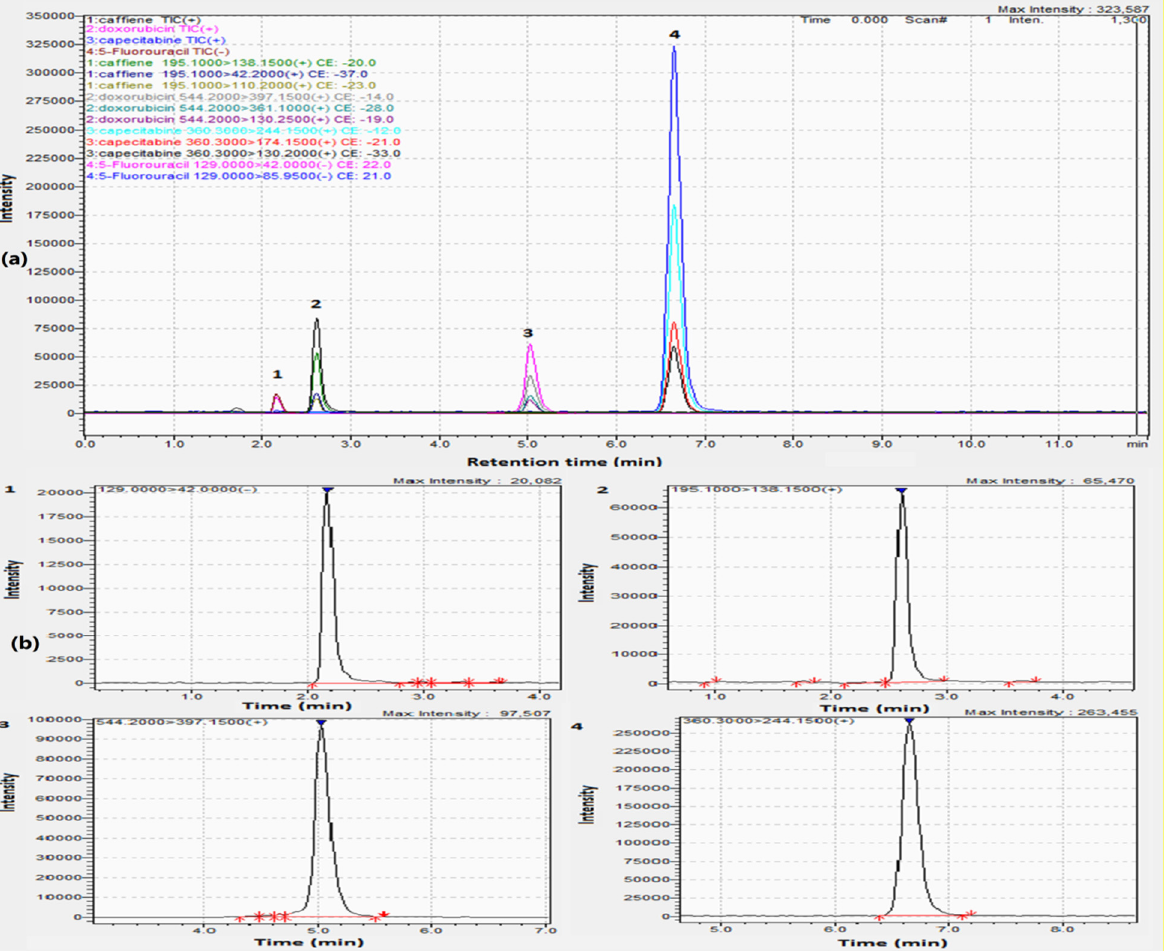
Figure 2. ( a ) TIC and ( b ) extracted ion chromatograms of 1 . (200.00 ng/mL) 5-Fluorouracil, 2 . (50.00 ng/mL) Caffeine, 3 . (100.00 ng/mL) Doxorubicin, and 4 . (20.00 ng/mL) Capecitabine.